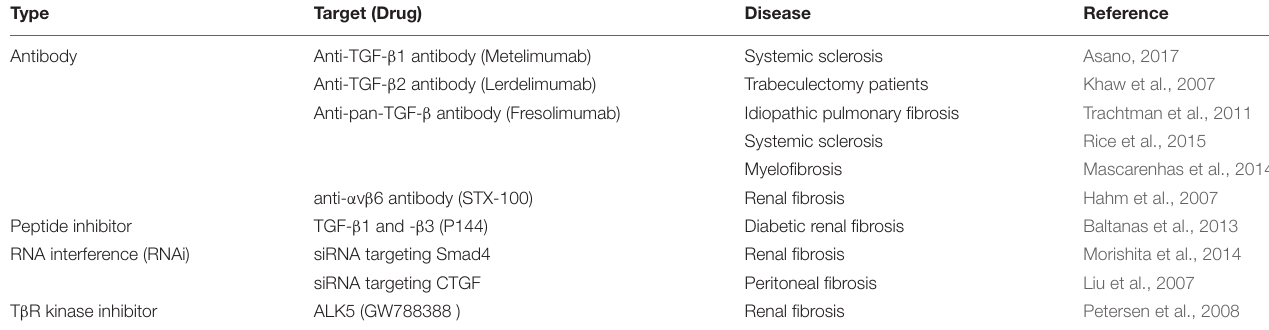
TABLE 1 | Therapeutic agents targeting TGF- β in various fibrotic